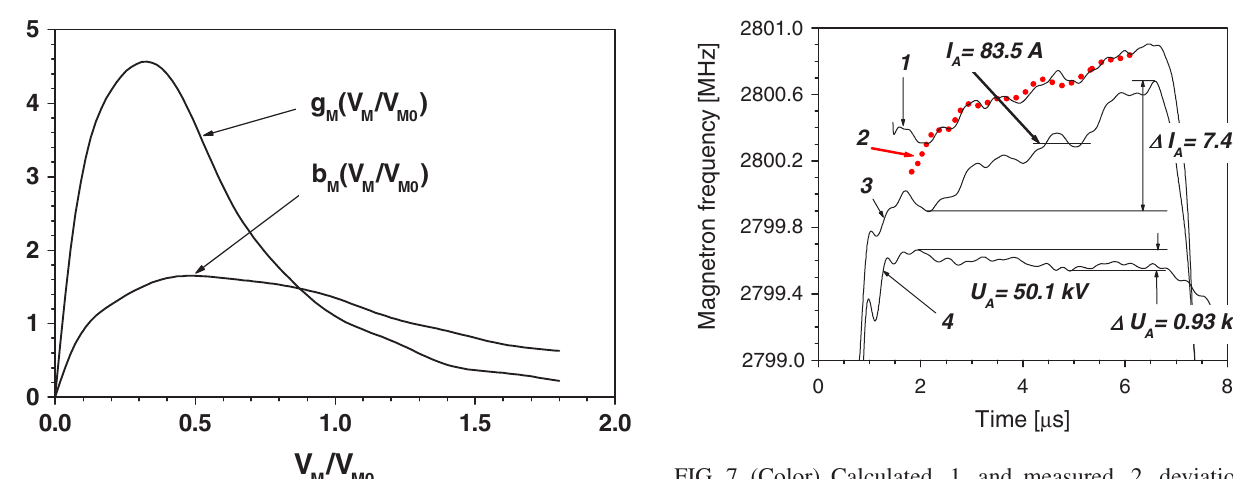
FIG. 7. (Color) Calculated, 1, and measured, 2, deviations of the frequency of the magnetron loaded by a passive waveguide , and susceptance, b , of the magne- load during the macropulse vs the time-dependent magnetron M M =V current, 3. M M 0